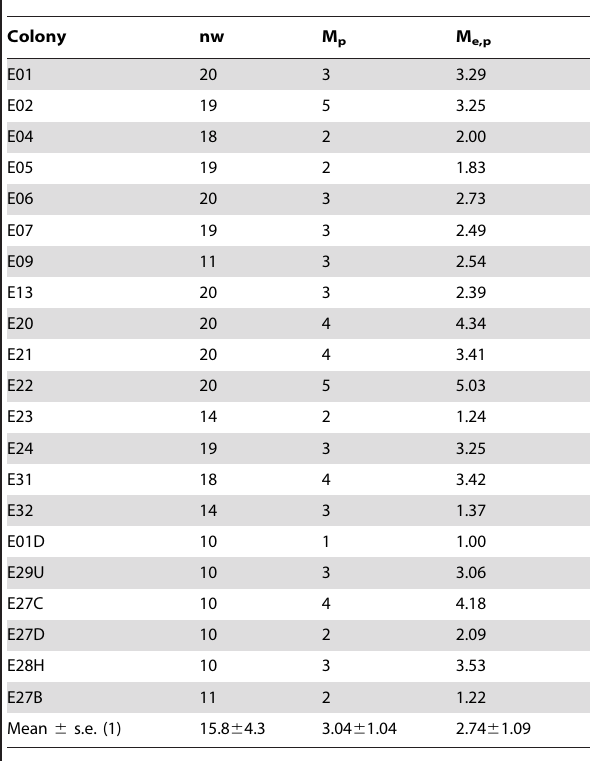
Table 2. Queen mating frequency in C. emmae .